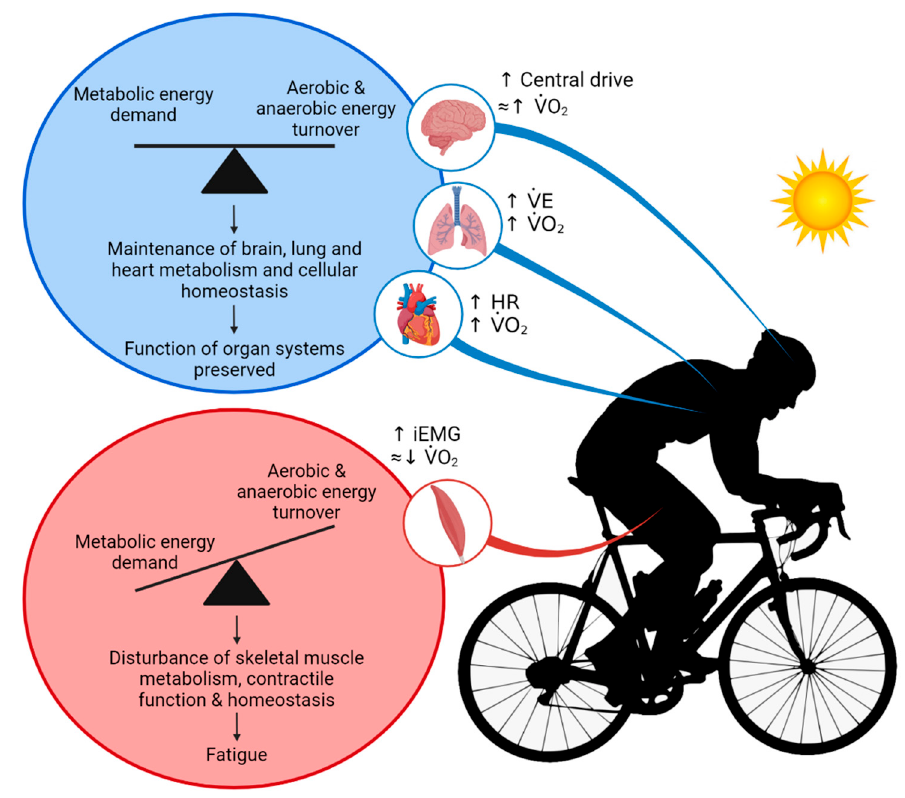
Figure 7. Physiological function and cellular homeostasis during fatiguing exercise. This figure illustrates a theoretical model of the physiological responses to maximal aerobic exercise, with and without environmental heat stress. While the available evidence suggests that compensatory adjustments preserve function and cellular dynamic homeostasis in the brain, the lungs and the heart, a mismatch between energy demand and supply in contracting skeletal muscle leads to compromised local metabolism, suppressed muscle contractile function, impaired force production and ultimately an inability to maintain speed of locomotion or power output, the hallmark of fatigue. Note in Figures 1 and 5 that the rate of rise in exercising legs blood flow is blunted above moderate exercise intensities during incremental two-legged cycling, but not during incremental single leg knee-extensor exercise. The addition of moderate-to-severe whole-body hyperthermia, or combined dehydration and hyperthermia during constant load and incremental exercise (Figures 2–5) induce a faster attenuation in the rate of rise or a decline in exercising legs blood flow, leading to disruption in myocyte dynamic homeostasis and accelerated fatigue. In contrast, skin hyperthermia alone— induced via a brief heat exposure using a water-perfused suit—does not speed up fatigue compared to control (Figure 5). Importantly, as illustrated by the exercising legs blood flow in Figure 1, alterations in physiological function and compromised locomotor muscle metabolism can also occur during maximal aerobic exercise in normothermic conditions, underpinned by restrictions in exercising limb blood flow and diminished O 2 supply. Created with